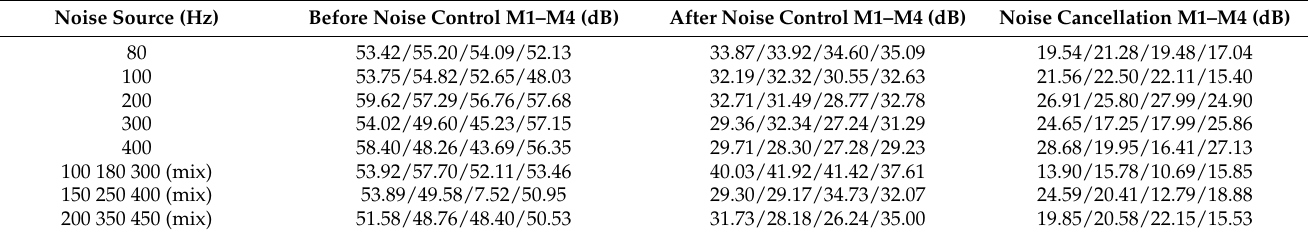
13 of 19 Figure 9. Vehicle multi ‐ channel fractional ‐ order ANC experimental system. ( a ) Laboratory equip- ment deploymen; ( b ) Arrangement of external sound source of noise in anechoic room; ( c ) Ar- rangement of internal sensors and speakers in anechoic room. 3.4. Noise Cancellation of External Spherical Sound Source of Vehicle The secondary path was identified and the secondary sound source was achieved by playing white noise. The signals collected by error microphones M1, M2, M3, and M4 were used to identify the secondary path in the driving and copilot positions. The pri- mary sound source was played with noise signals of different frequencies (The frequen- cy is between 80 – 500 Hz), which were collected by the reference microphone. The error microphone collected the residual noise signals and then transmitted them to the con-